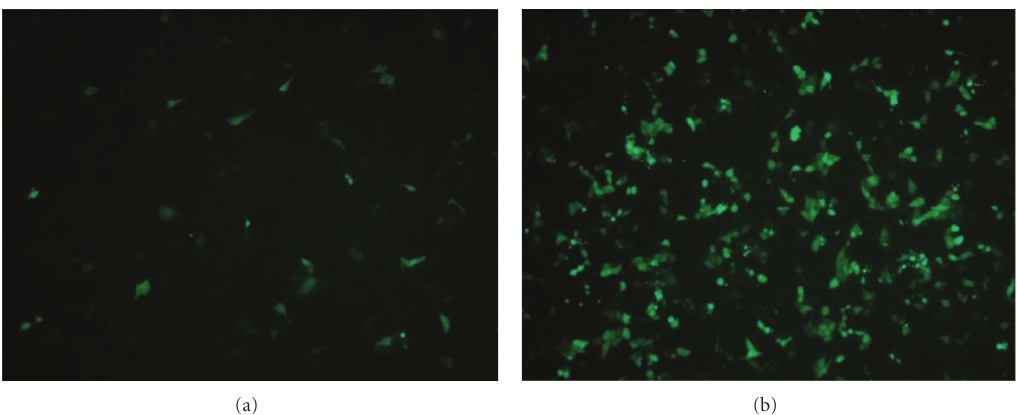
Figure 4: Fluorescent micrograph of the transfected PK-15: (a). Fluorescent micrograph of the PK-15 cells transfected without a magnetic field. (b) Fluorescent micrograph of the PK-15 cells transfected under a magnetic field. The results showed that the transfection e ffi ciency can be significantly enhanced with magnetic